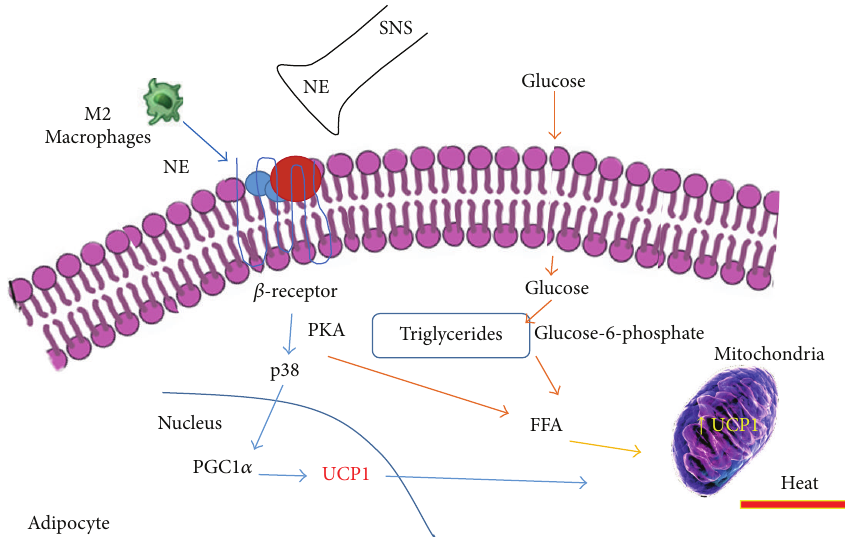
Figure 1: The effects of cold on the induction of thermogenic active adipocyte. The secretion of norepinephrine (NE) directly from nervous sympathetic system or indirectly through catecholamine secretion by macrophage type 2 can stimulate glucose uptake in fat cells and improve the regulation of carbohydrate. Both glucose and triglycerides are used by UCP1 protein to increase thermogenesis. FFA: free fatty acid; M2: macrophages 2, SNS: sympathetic nervous system; PKA: protein kinase A; UCP1: uncoupling protein 1; PGC-1 𝛼 : peroxisome proliferator- activated receptor-gamma coactivator alpha